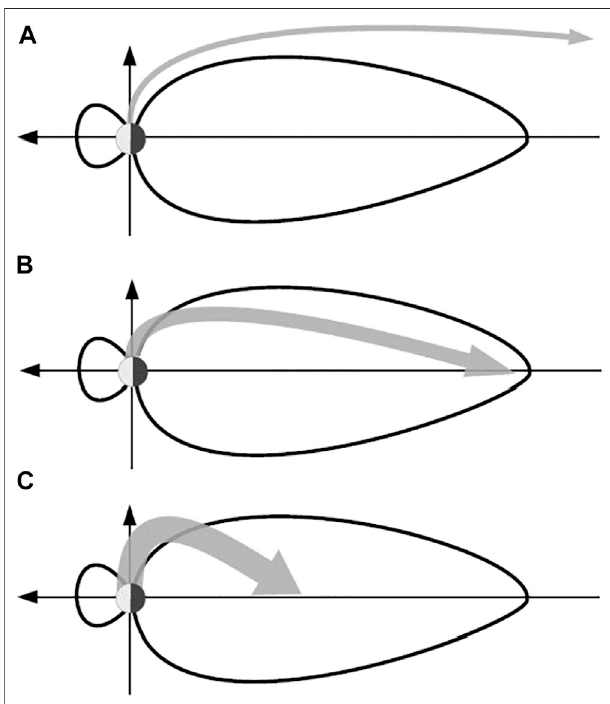
FIGURE 4 | Schematic plots of the trajectories of cold ions during (A) quiet, (B) moderate, and (C) storm periods. The width of the grey arrow in each panel indicates the fl ux of cold ions. The geomagnetic quiet conditions correspond to near stagnant magnetospheric convection, with relatively small out fl ow fl uxes from the ionosphere. Strong magnetospheric convection happens during the geomagnetic storm periods. Although the out fl ow fl uxes are large compared to that during the quiet periods, most of the cold ions reach the plasma sheet before moving far down-tail. From Haaland et al.